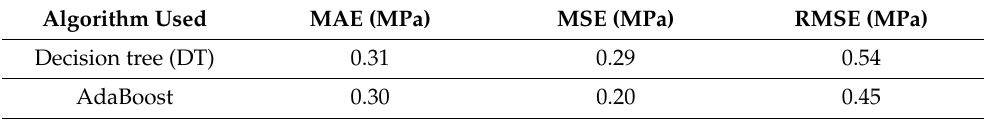
Table 6. Statistical checks for splitting tensile